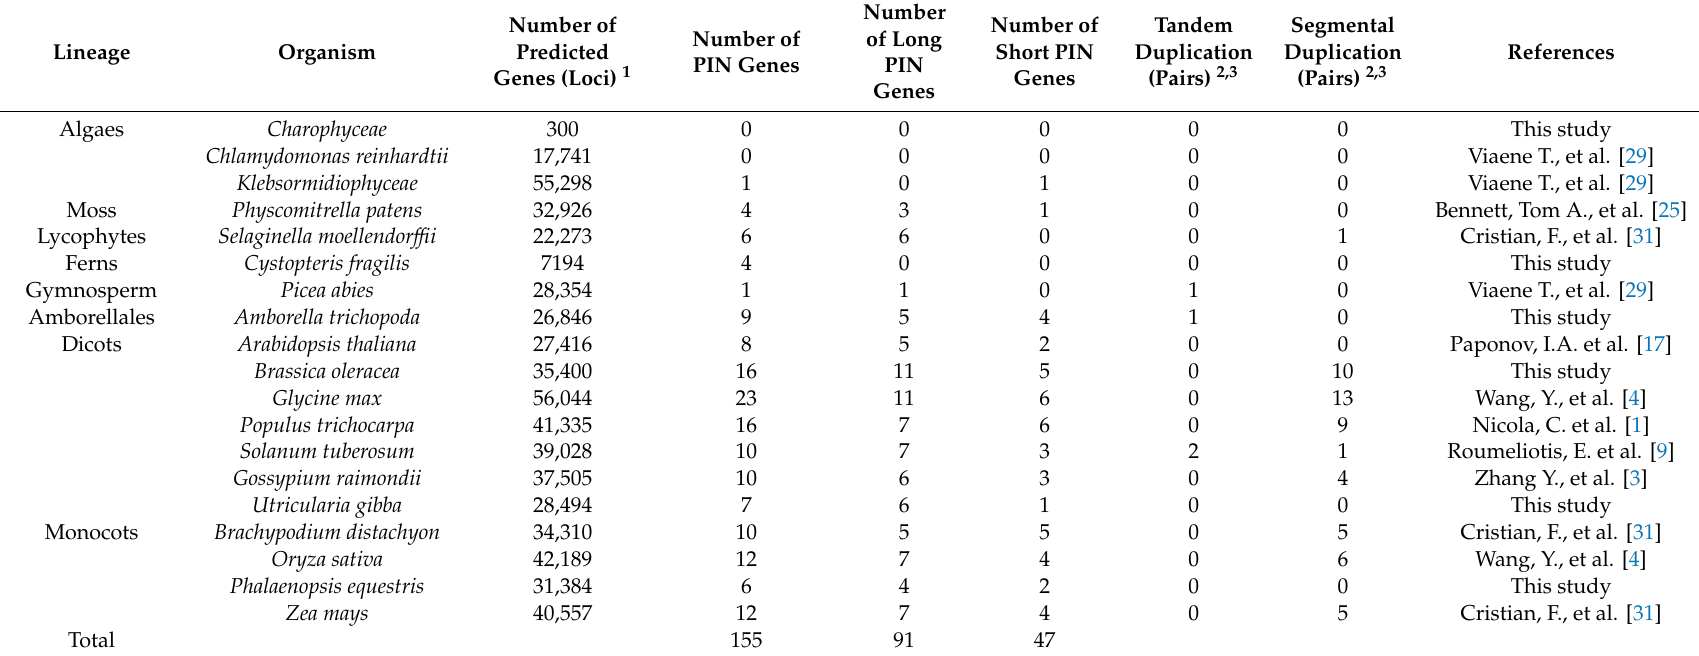
Table 1. PIN-FORMED (PIN) genes identified in 19 sequenced plant